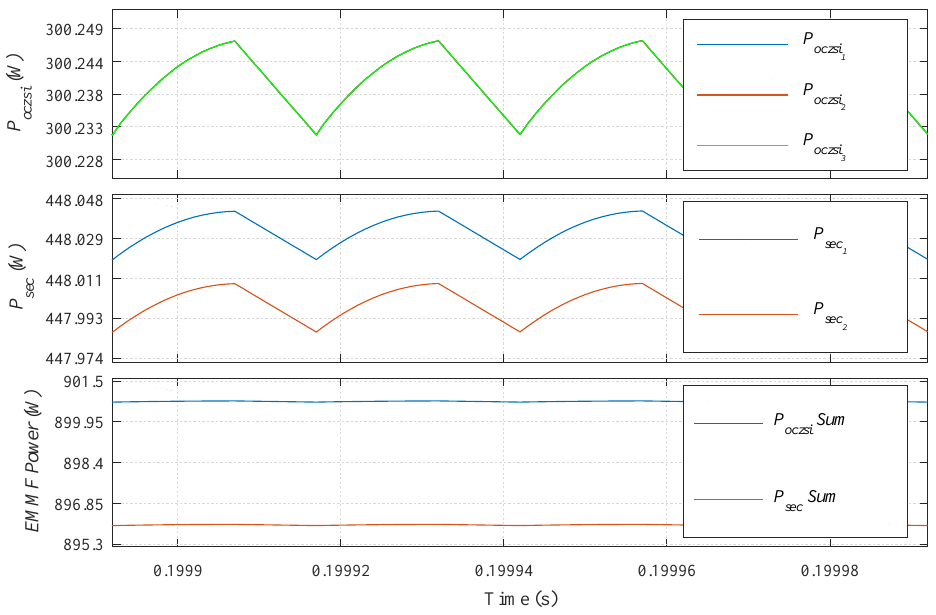
Figure 8. CZSI simulation results: Average power in primary ports and average power in secondary ports under balanced power operation.